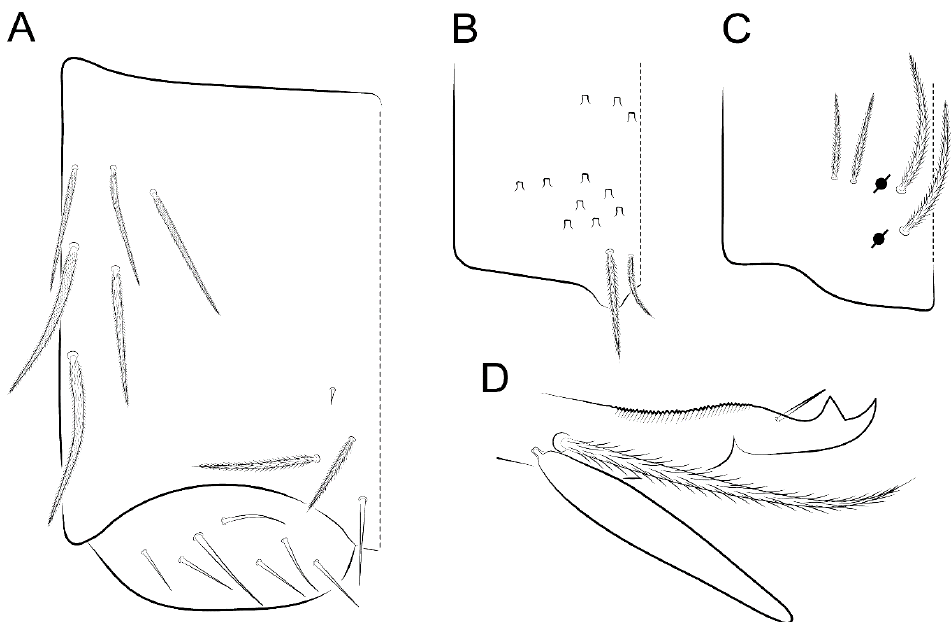
Figure 11. Pseudosinella acantholabrata sp. nov. ( A ) collophore (lateral view); ( B ) distal part of manubrium (ventral view); ( C ) manubrial plate (dorsal view); and ( D ) distal dens and mucro (outer view).